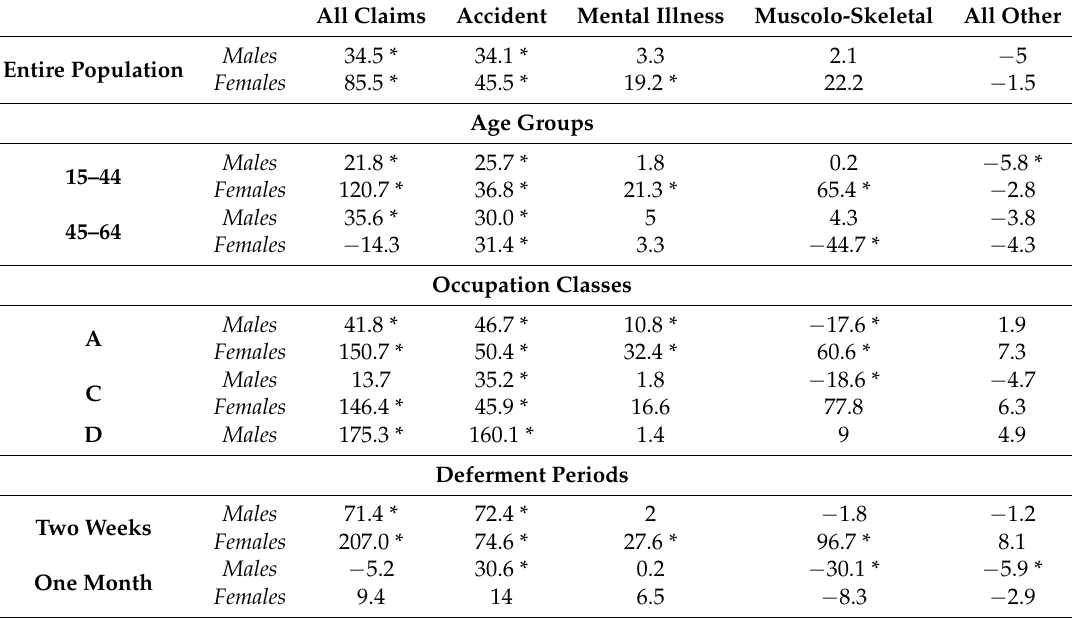
Table 5. Average change in number of claims for 1% increase in unemployment rate. All Claims Accident Mental Illness Muscolo-Skeletal All